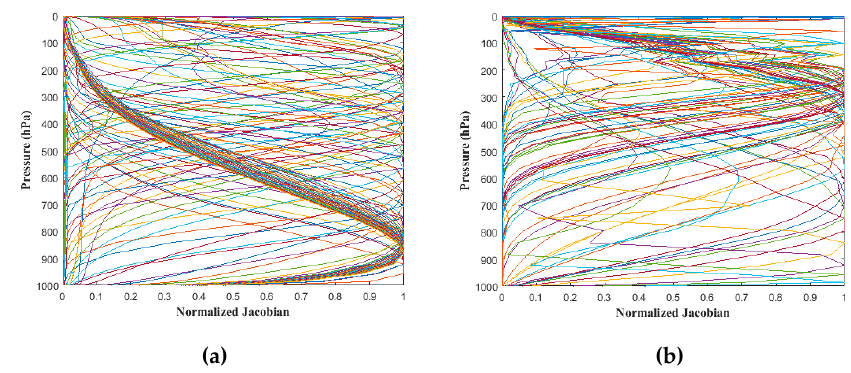
Figure 3. ( a ) The normalized Jacobian of the selected temperature channels and ( b ) the normalized Jacobian of the selected humidity channels. Different colors represent different channels.